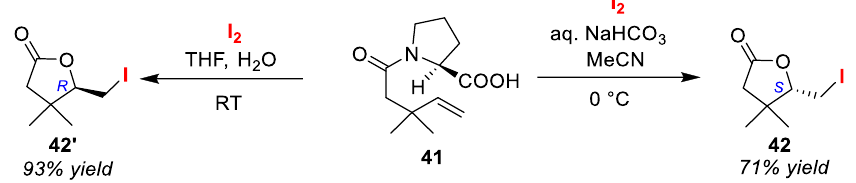
Figure 21. Unique enantio-controlling iodolactonization of olefinic amide 41.